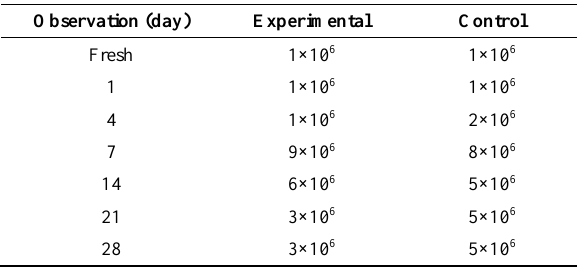
Table 2. Bacterial count (CFU/g) in preserved goat